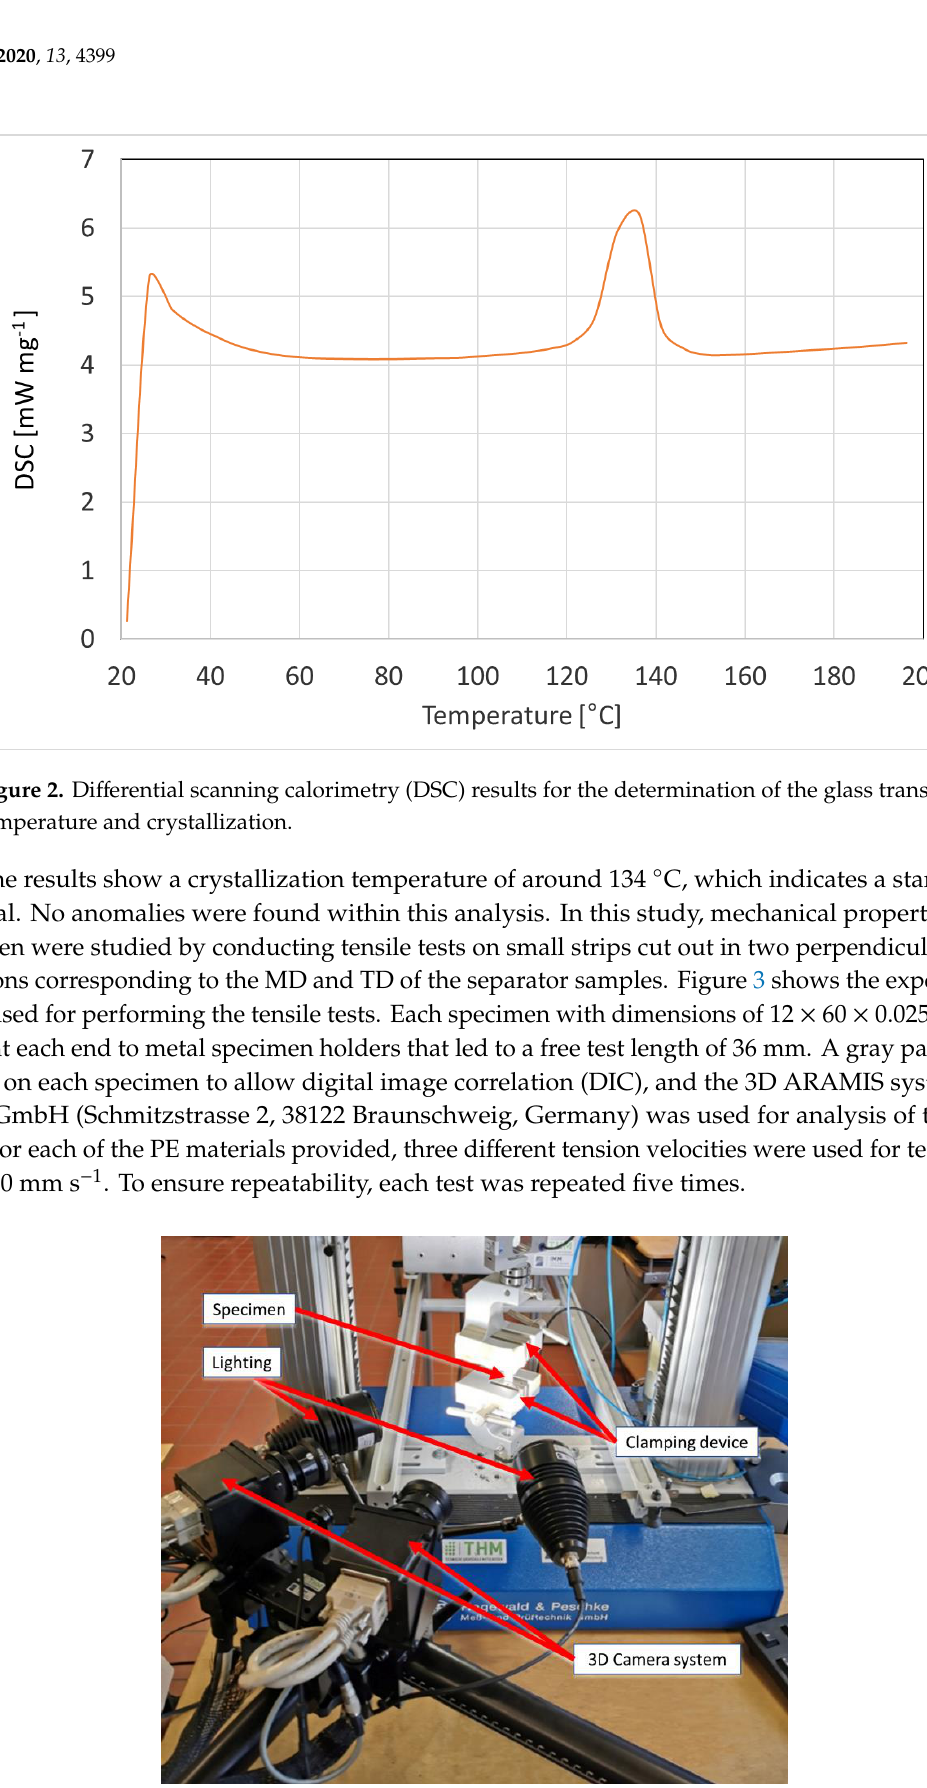
Figure 3. Experimental setup for the tension tests on the polyethylene (PE) isolator specimen.